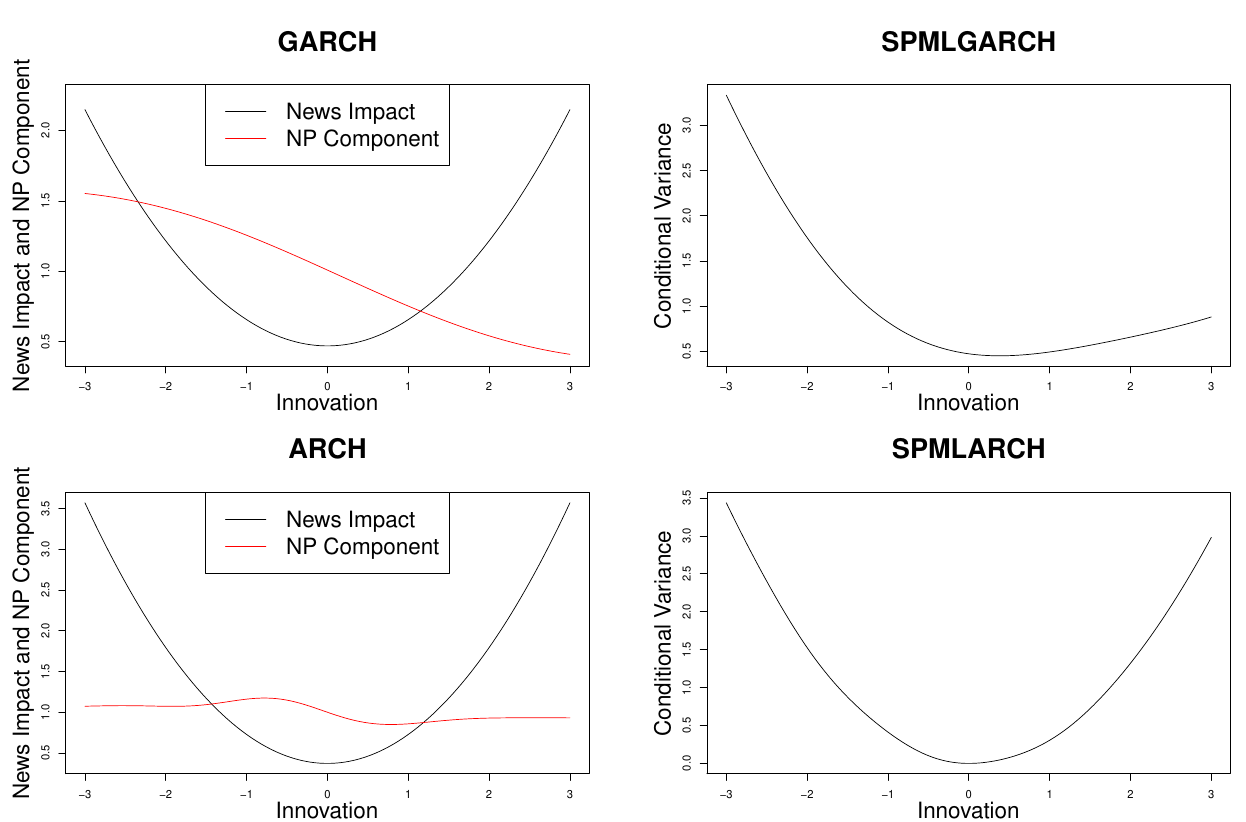
Figure 1. The left two plots show the news impact curves in black and second-stage nonlinearities in red for S&P 500 daily returns. The right two plots show the conditional variance estimates for SPMLGARCH and SPMLGARCH.